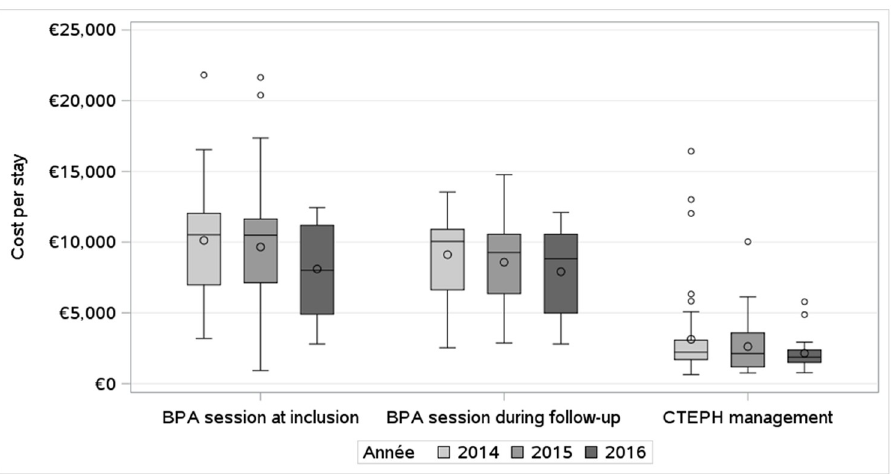
Fig 2. Evolution of mean hospital cost per stay over year of